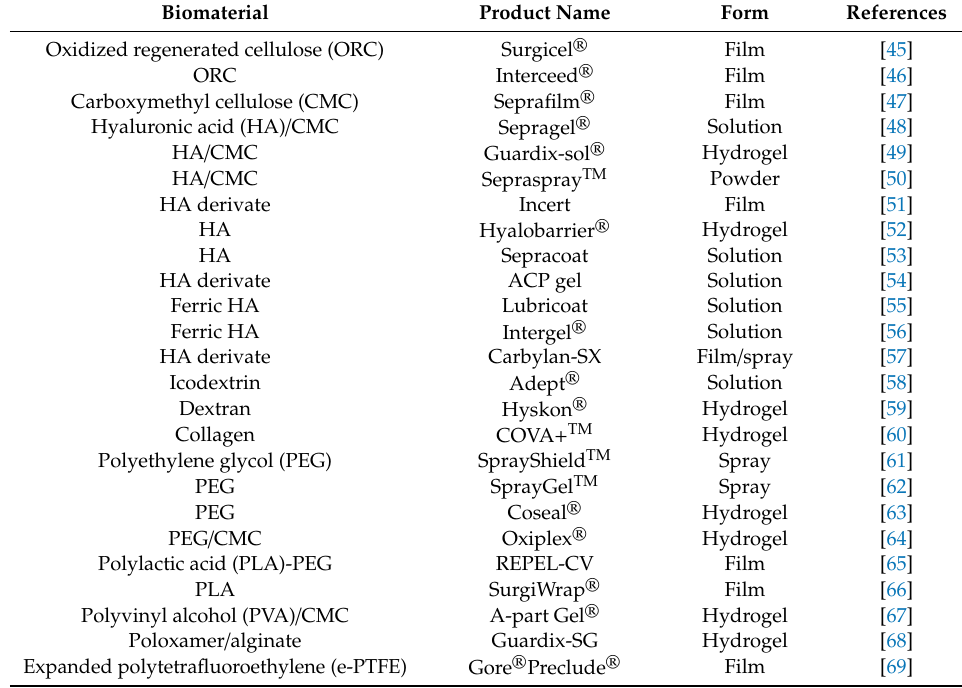
Table 2. Various forms of anti-adhesion